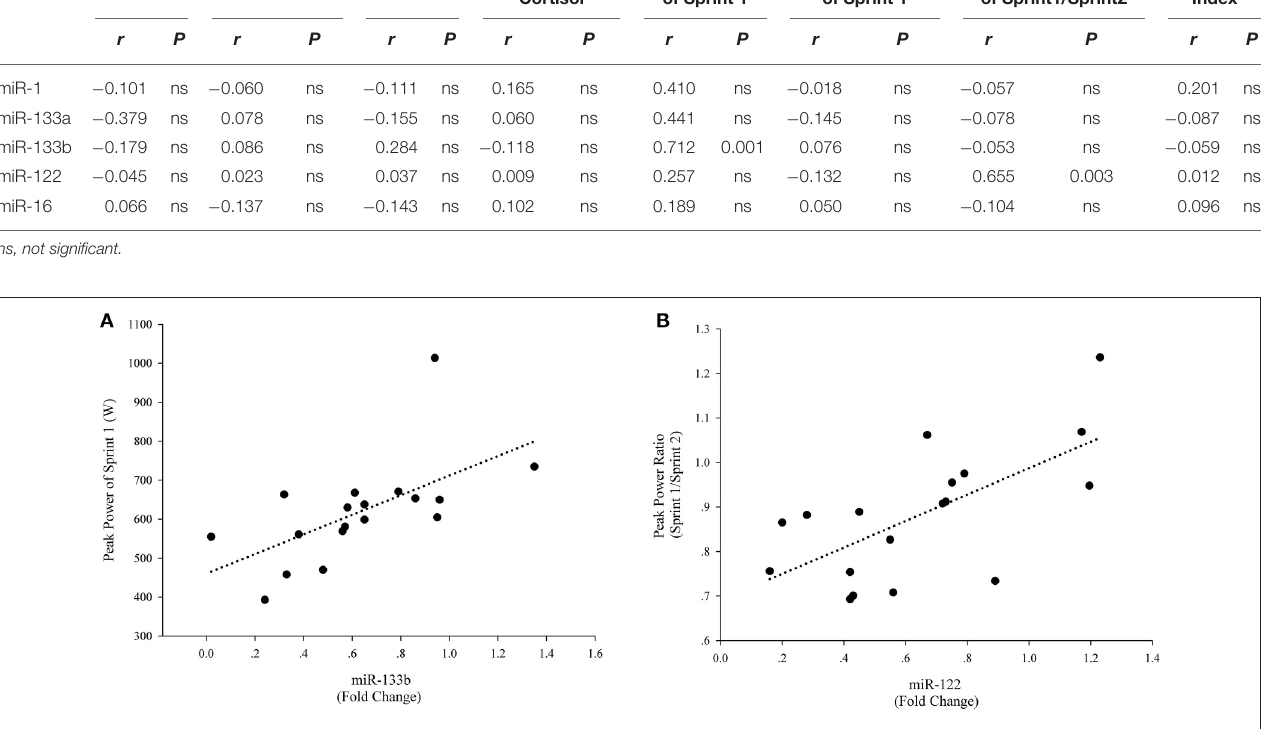
TABLE 1 | Correlations between changes in exercise-related blood parameters and anaerobic parameters and changes in plasma levels of miRNAs ( n = 18 ). IGF-1 Testosterone Cortisol Testosterone/ Peak Power Average Power Peak Power Ratio Fatigue Cortisol of Sprint 1 of Sprint 1 of Sprint1/Sprint2 Index